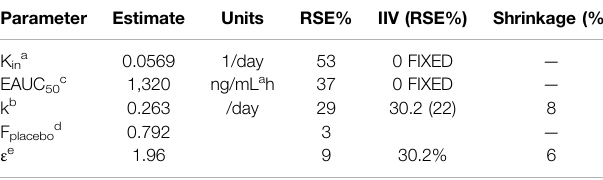
TABLE 1 | Parameter estimation results for the exposure-response